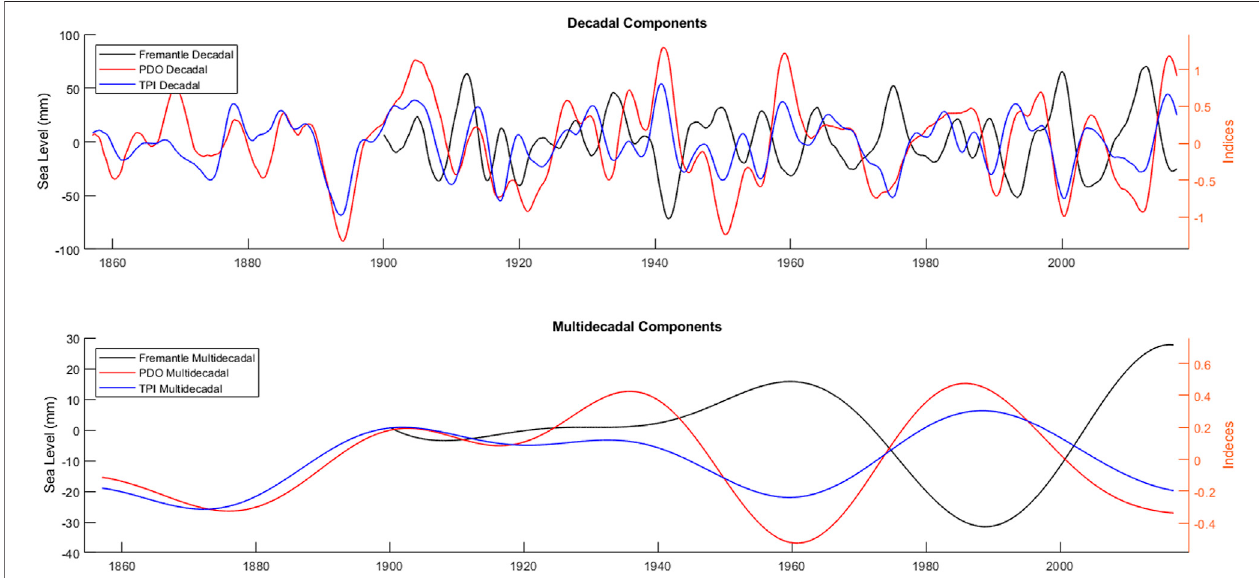
FIGURE2| Decadal (toppanel) andmultidecadal (bottompanel) componentsofSLA,TPI,andPDO.Todecomposethecomponentsfromthelow-passedtime series,continuouswaveletanalysisisapplied.Thedecadal componentsarereconstructedfromsignalsshorterthan37 years(maximum resolvableperiod forSLAusing Morlet wavelets) of the corresponding data set. The multidecadal components, on the other hand, resulted from subtracting the decadal component from low-passed counterpart in Figure 1 .